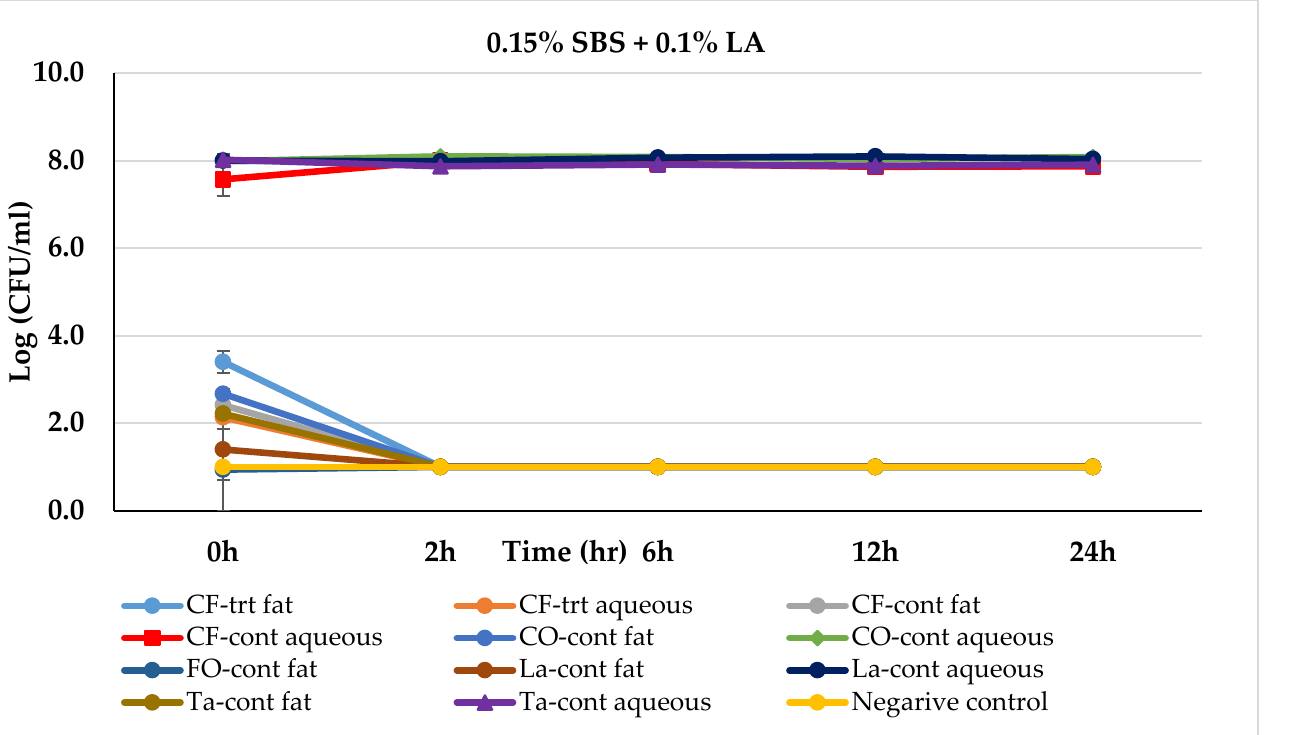
Figure 5. Mean logarithmic counts (log CFU/mL) of Salmonella spp. in different fat and oil systems with and without the inclusion of 0.15% SBS and 0.1% lactic acid evaluated separately for the aqueous phase and fat phase at 45 °C. Treatments from each phase were plated on TSA at different times. SBS, sodium bisulfate; CF, chicken fat; CO, canola oil; FO, fish oil; La, Lard; Ta, Tallow; Cont., control. Negative control consisted of fat-oil system without acidulant and Salmonella inoculation. The limit of detection is 1 log CFU/mL for this study. Because the three replications were averaged, for some of the treatments, the counts on 0 h appeared to be lower-than-detection limit. Error bars are ± 1 standard error of the mean.